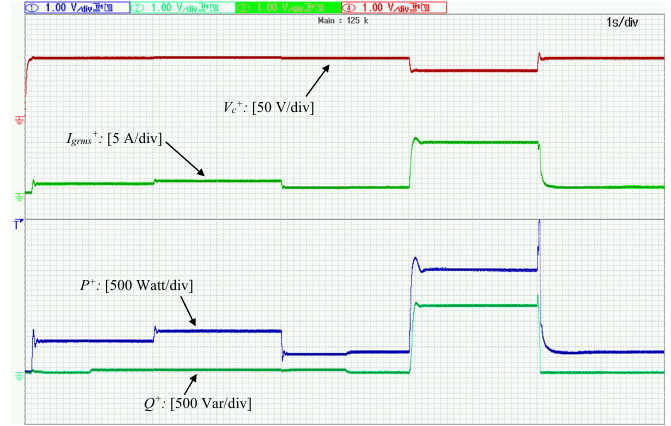
Figure 4. Operation under balanced conditions with a 0.4p.u. balanced voltage drop at 6